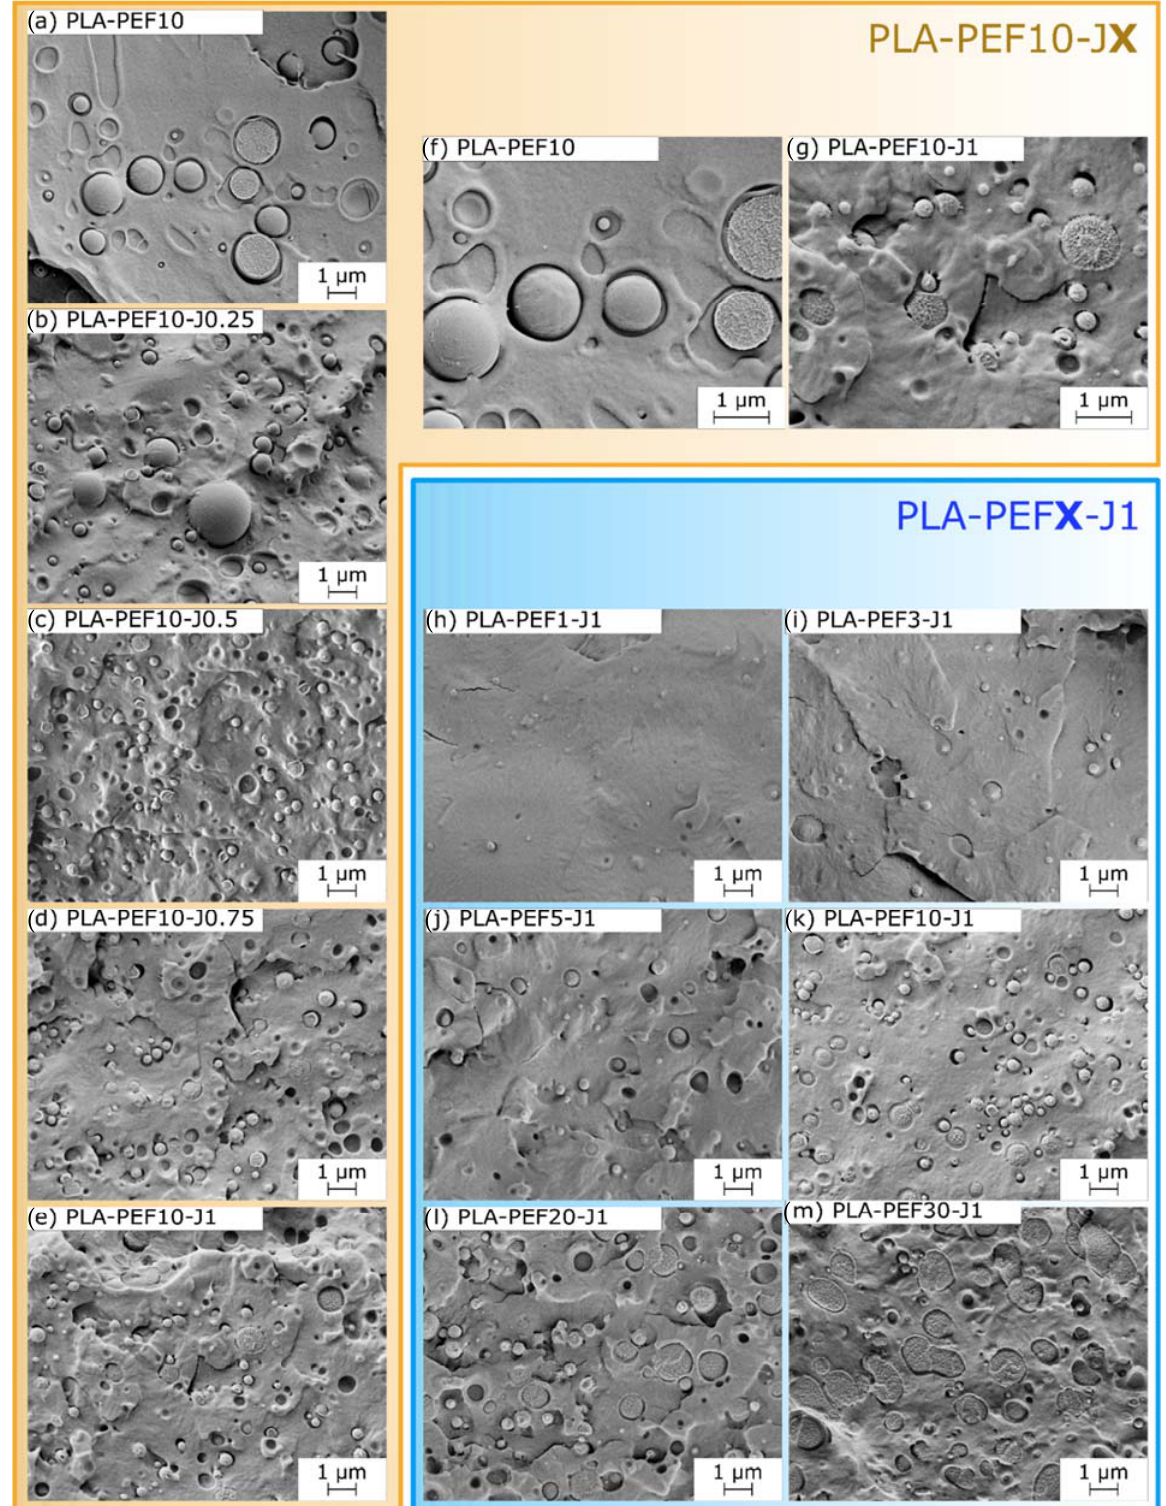
Figure 2. SEM micrographs of the cryofracture surface of the prepared samples. ( a–e ) PLA ‐ PEF10 ‐ Jx (x = 0–1 phr); ( f–g ) comparison between PLA ‐ PEF10 and PLA ‐ PEF10 ‐ J1, at higher magnification; (h–m) PLA ‐ PEFx ‐ J1 (x = 1–30 wt %).